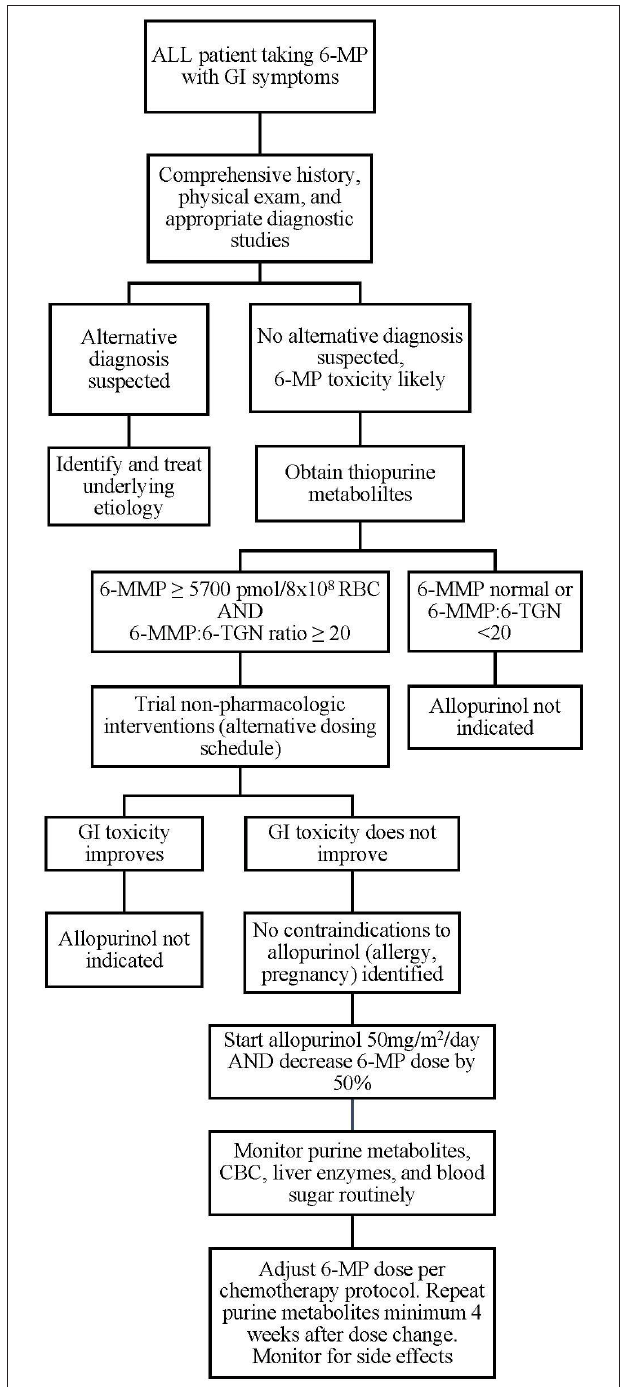
FIGURE 2 | Proposed algorithm for evaluation and implementation of allopurinol for 6-MP associated GI toxicities. 6-MP, 6-mercaptopurine; 6-MMP,